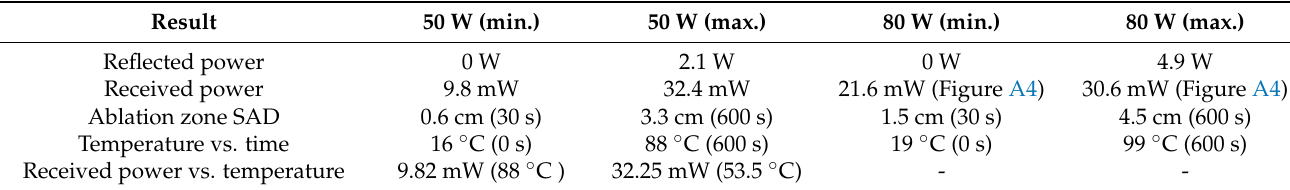
Table 3. Summary of all quantitative results for 50 W and 80 W MWA experiments with